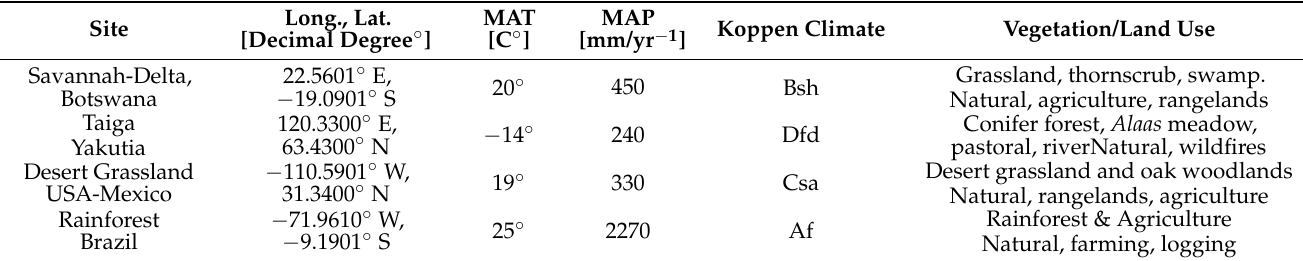
Figure 4. Four example ecosystems with varying vegetation types, disturbance and land use practices, and climatic conditions. Table 4. Locations mean annual temperature (MAT, ◦ Celsius), mean annual rainfall (MAT, millimeters per year), Koppen Climate Classification [103], and vegetation type